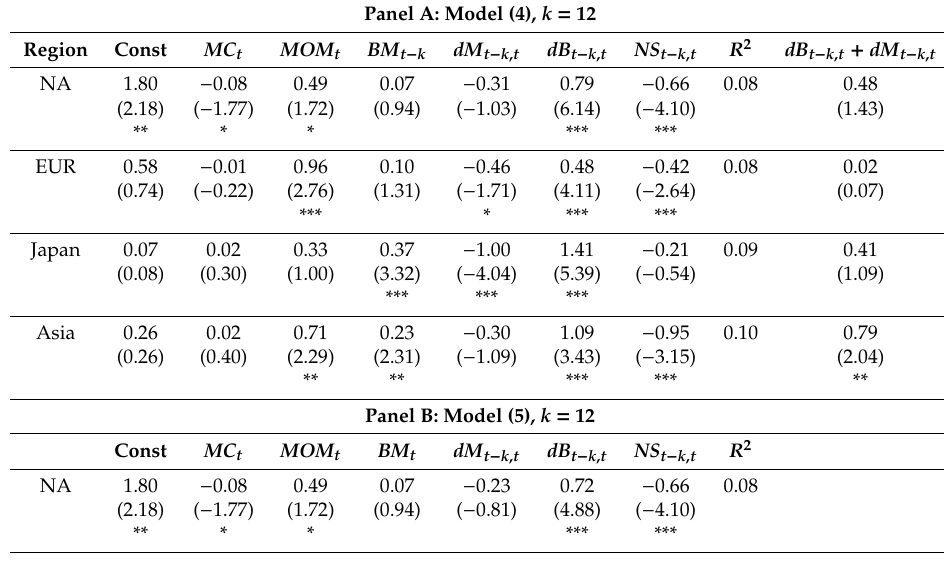
Table 4. Models (4) and (5) Regression Estimates—Big Stocks, 1991–2016. Results presented in Panel A are based on the same analysis of Model (4) as described in Table 2, and results presented in Panel B are based on the same analysis of Model (5) as described in Table 3. Regressions here use the set of big stocks defined as the set of stocks with the largest market capitalization that in aggregate comprise 90% of the total market cap for each region. *** / ** / * indicates significance at the 1, 5, and 10% level,